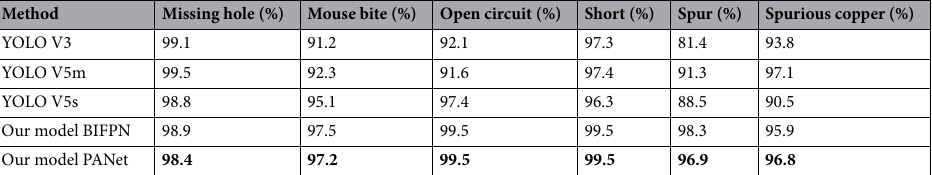
Table 2. Mean average precision (mAP) achieved with IoU = 0.50 for PCB manufacturing defect classification across defect types. The values in bold represent the results of the proposed model.